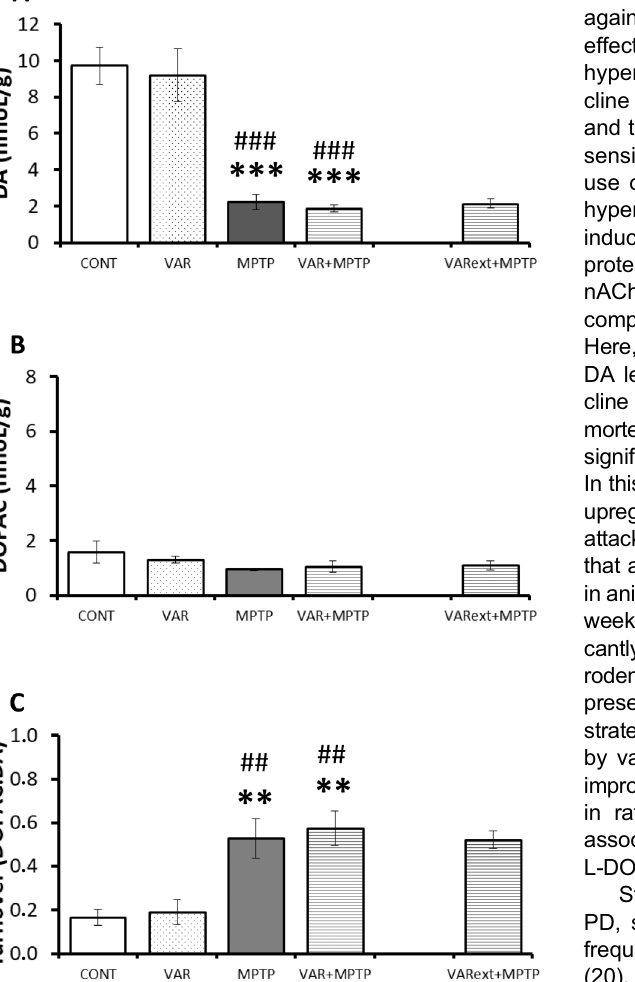
Figure 2. Effects of chronic varenicline exposure on dopamine (DA) levels ( A ), 3,4 dihydroxyphenylacetic acid (DOPAC) levels ( B ), and turnover ( C ) in a 1-methyl-4-phenyl-1,2,3,6-tetrahydro- pyridine (MPTP) mouse model of Parkinson ’ s disease. Data are reported as means ± SE. **P o 0.01, ***P o 0.001 vs control; ## P o 0.01, ### P o 0.001 vs VAR (ANOVA followed by Fisher protected least signi fi cant difference). CONT: saline injections; MPTP: saline + MPTP; VAR: 2 mg/kg of varenicline +